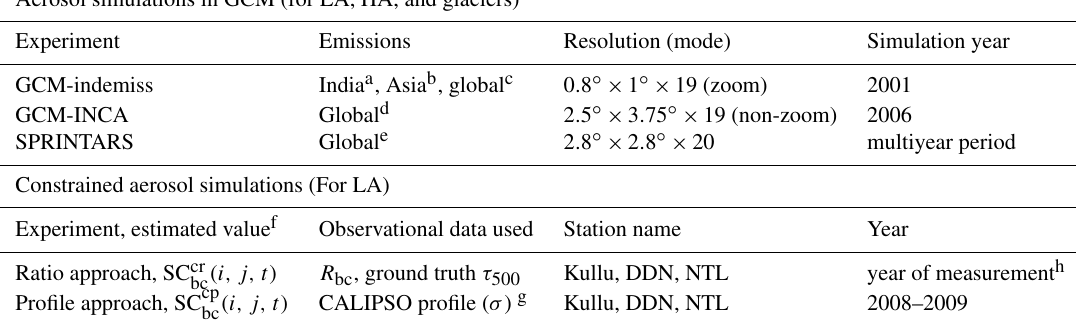
Table 2. Details of BC simulation used in this study. Aerosol simulations in GCM (for LA, HA, and